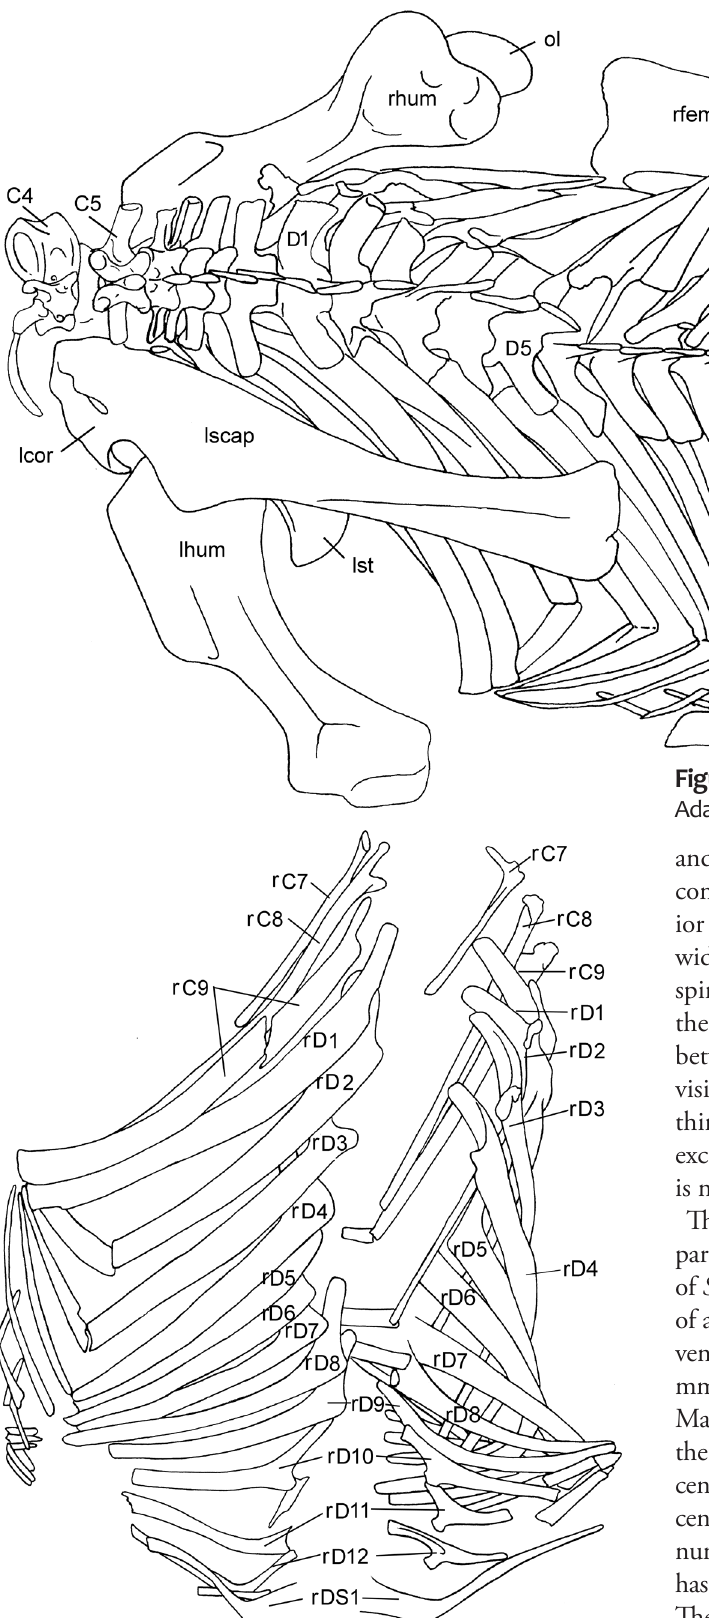
Figure 2. Specimen map showing relative position of ribs. Vagaceratops irvinensis , CMN 41357. Adapted and simplified from a map prepared by D.